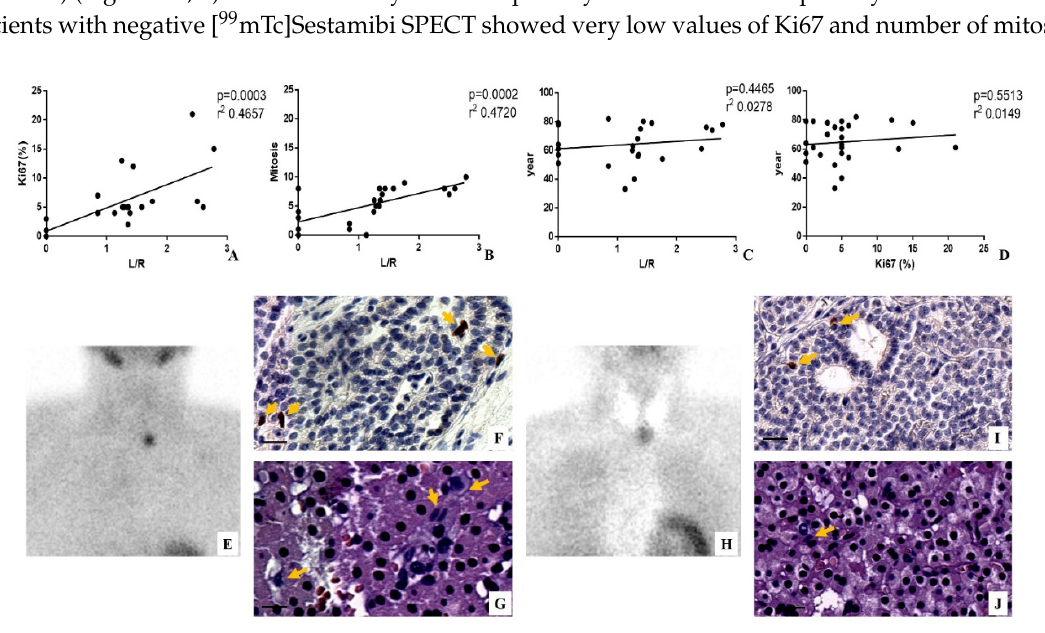
Figure 2. Evaluation of sestamibi uptake and proliferation index in patients affected by hyperparathyroidism. ( A ) Graph shows linear regression analysis between the percentage of Ki67 positive cells and lesion to nonlesion (L/N) ratio. ( B ) Graph displays linear regression analysis between the number of mitosis and L/N ratio. ( C ) Graph shows linear regression analysis between patients’ year and L/N ratio. ( D ) Graph displays linear regression analysis between patients’ year and the percentage of Ki67-positive cells. ( E ) Image shows [ 99 mTc]Sestamibi uptake in a 74-year-old woman with primary hyperparathyroidism. A parathyroid carcinoma (0.8 cm) was identified after the surgery by histological analysis. To evaluate the parathyroid sestamibi uptake, that of the thyroid has been subtracted. ( F ) Representative image of immunohistochemical reaction for ki67. Several positive Ki67 cancer cells are labeled by arrows. ( G ) Hematoxylin–eosin (H&E) staining shows several mitosis (arrows). ( H ) Image displays no [ 99 mTc]Sestamibi uptake in a 40-year-old woman with primary hyperparathyroidism. A parathyroid adenoma (0.4 cm) was identified after the surgery by histological analysis. ( I ) Representative image of immunohistochemical reaction for Ki67. Rare positive Ki67 cancer cells are labeled by arrows. ( J ) H&E staining shows rare mitosis (arrows). Scale bar represents 100 μm in all images.